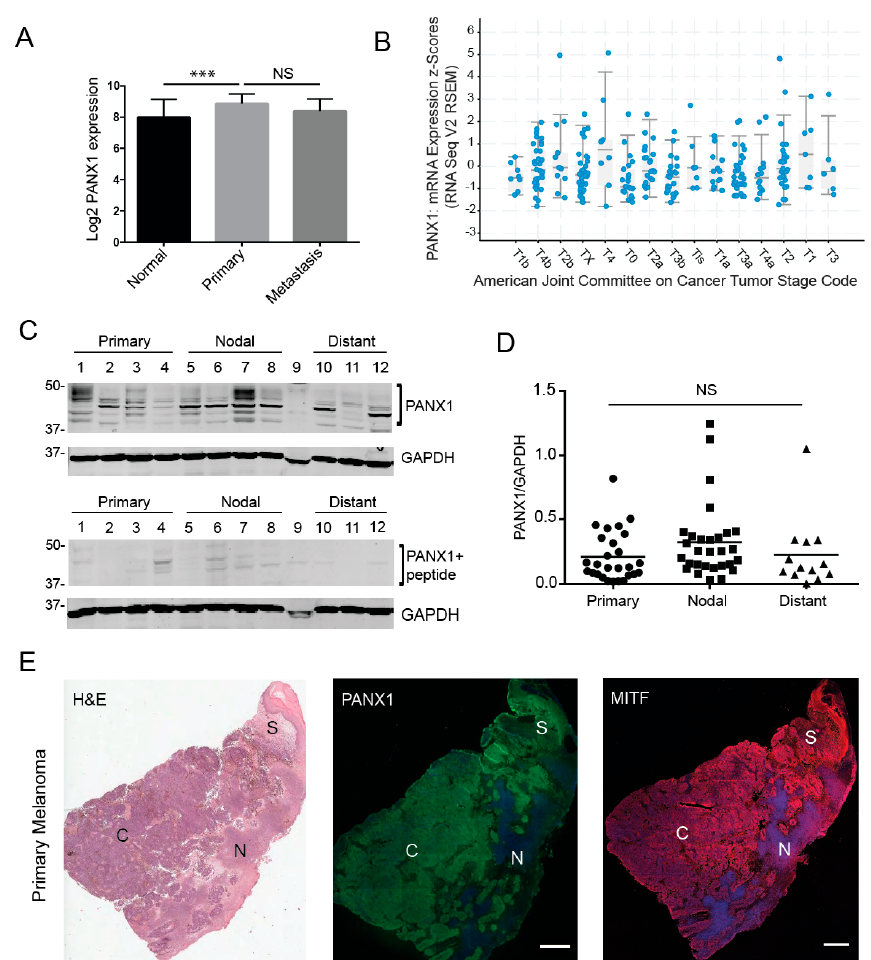
Figure 1. Pannexin 1 is expressed in patient-derived primary melanoma tumors, as well nodal and distant melanoma metastases. ( A ) Gene expression analyses from microarray study GSE15605 revealed significantly higher PANX1 expression in primary human melanoma tumors relative to normal skin biopsies. ( B ) Analysis of PANX1 mRNA expression in melanoma tumors of the Cancer Genome Atlas (TCGA) database revealed that PANX1 expression is not significantly different across melanoma stages (denoted according to the Cancer Tumor Stage Code). ( C ) Representative PANX1 protein levels in patient-derived melanoma tumors. Numbers represent different patient donors. A peptide pre-absorption assay confirms antibody specificity. Protein sizes in kDa. ( D ) Densitometry was used to quantify PANX1 levels (bands in bracket) in all primary, nodal and distant melanoma samples provided by the Ontario Institute for Cancer Research (OICR), normalized to GADPH (Sample 9 was degraded and not used for analysis). There is no significant difference in PANX1 levels among stages of melanoma progression. Primary tumors (N = 6 patients, n = 27 technical reps), Nodal mets (N = 7, n = 29), Distant mets (N = 3, n = 13); One-way ANOVA followed by Tukey’s post-hoc test was used to analyze data. line = mean; NS = not significant. ( E ) Patient-derived primary melanoma tumor labeled with PANX1 (green). Sequential sections of the tumor stained using H&E (provided by OICR) and a marker for a melanocytic-lineage, MITF (red). Melanoma core (C), Necrotic regions of the tumor (N), Stromal area of the tumor (S). Bar: 1000 μ m.